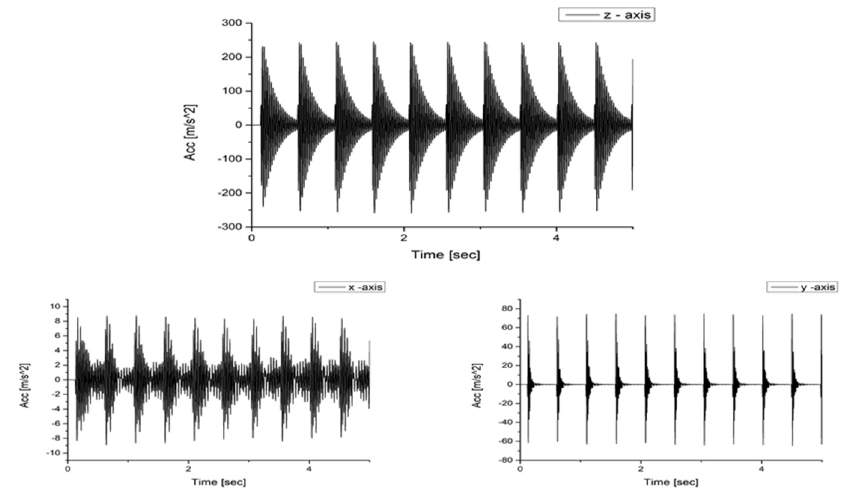
Figure 10. Acceleration signals of x, y, and z axis due to wheel flat impact against rail.